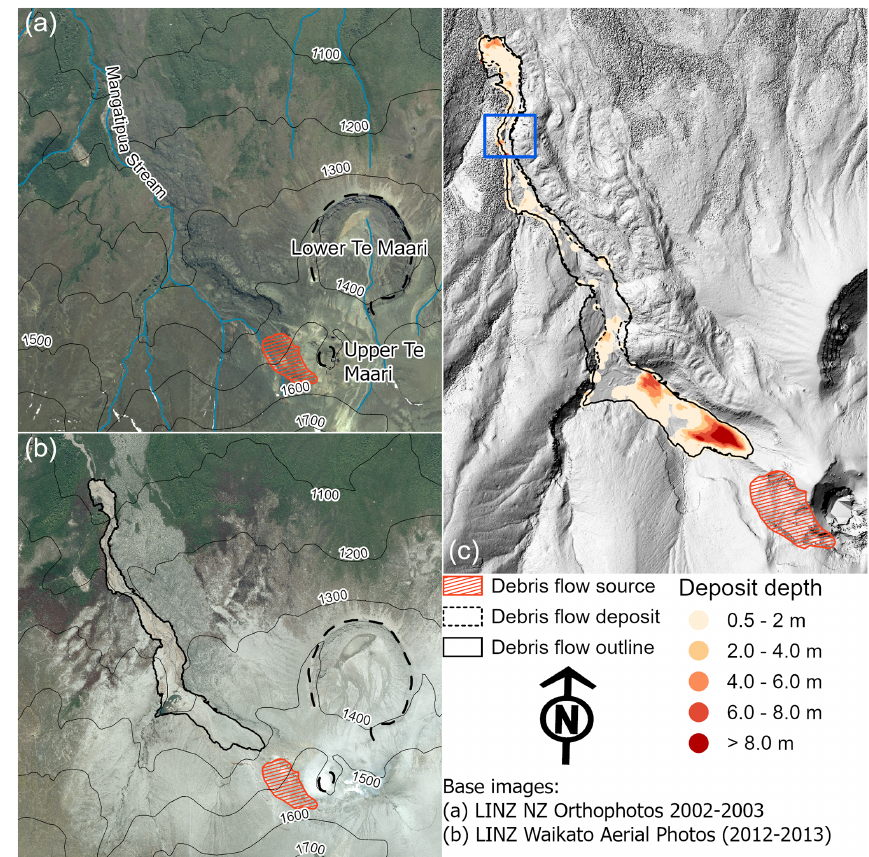
Figure 1. Te Maari debris avalanche case study region (a) pre-eruption, (b) post-eruption, and (c) debris avalanche deposit depth and outline. The blue rectangle in (c) shows area of spurious elevations from source digital terrain